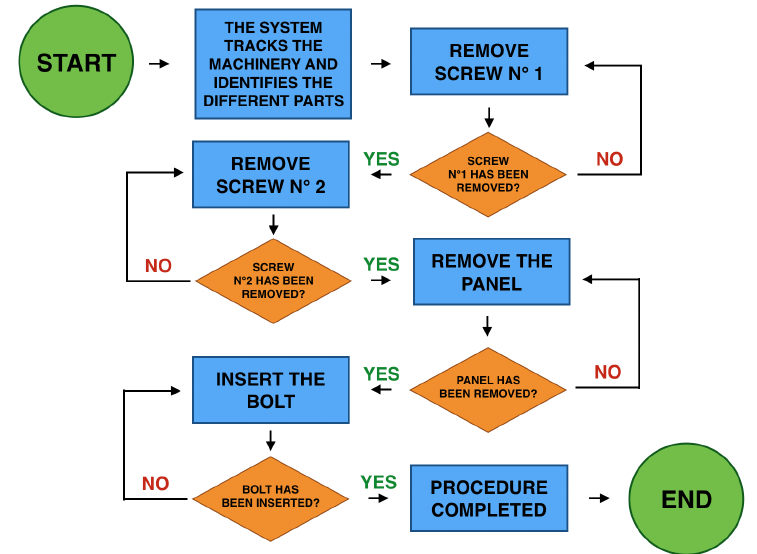
Figure 2. Example of state diagram describing the steps of a maintenance